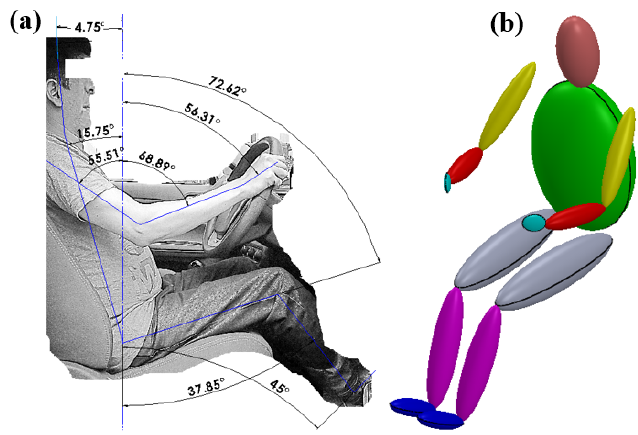
Figure 2. ( a ) Practical human male sitting on a car seat, and ( b ) established CAD (Computer Aided Design) model of human.